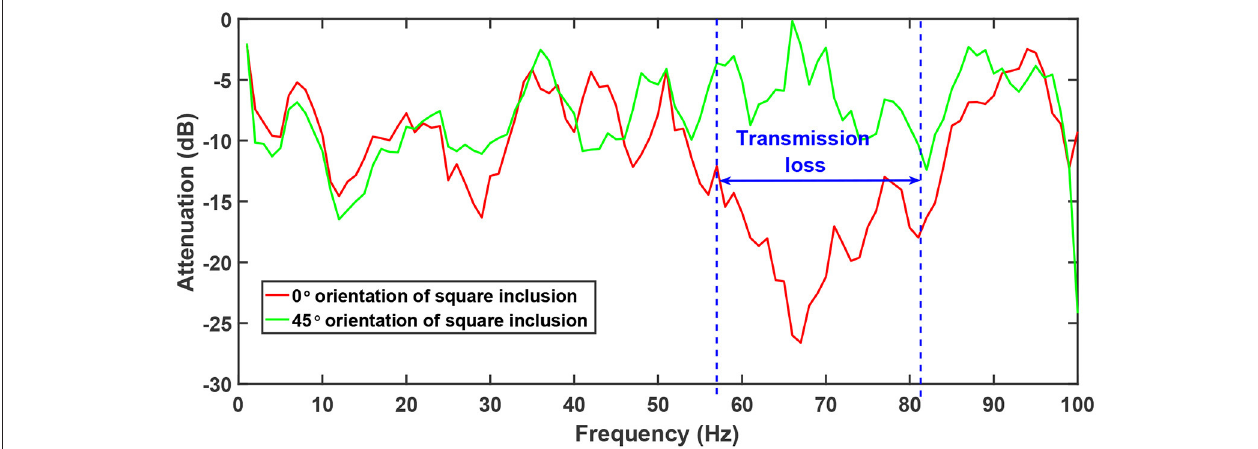
FIGURE 7 | Transmission spectra of 0 and 45 ◦ orientation of square steel inclusion in the medium soil matrix (bottom remains unclamped) are computed using a finite array of metamaterial design (corresponding to Figure 6 ). A dip is observed at ∼ 68 Hz, representing large wave